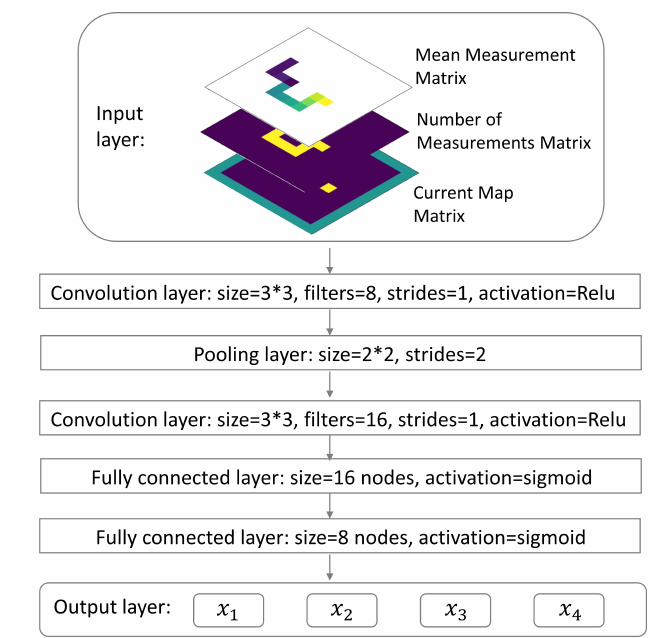
Figure 2. Schematic illustration of the convolutional neural network (CNN). The input of this CNN contains three images. The first image shows the mean radiation measurement for each of the visited positions. The second image shows the number of measurements for each position. The third image shows the detector’s current position in the searching area. The output layer is a fully connected layer with 4 nodes, and each of the nodes represents its corresponding action’s expected cumulative future reward given the input as current state. For the convolution layers or the pooling layer, the ’size’ parameter specifies the size of the convolution or pooling kernel; the ’filters’ parameter specifies the channel number of the convolution kernel; the ’strides’ parameter specifies the stride of the sliding window for each dimension of input; the ’activation’ parameter specifies the activation function applied to the output of the convolution results. For the pooling layer, we applied max pooling. For the fully connected layers, the ’size’ parameter specifies the number of nodes in the layer, and the ’activation’ parameter specifies the activation function applied to the output of the fully connected layer. The ’Relu’ activation function is defined as Relu ( x ) = max ( x ,0 ) , and the ’Sigmoid’ activation function is defined as Sigmoid ( x ) = e x . These definitions and names are consistent with the names 1 + e x used by the ’tf.layers.conv2d’ function in Tensorflow